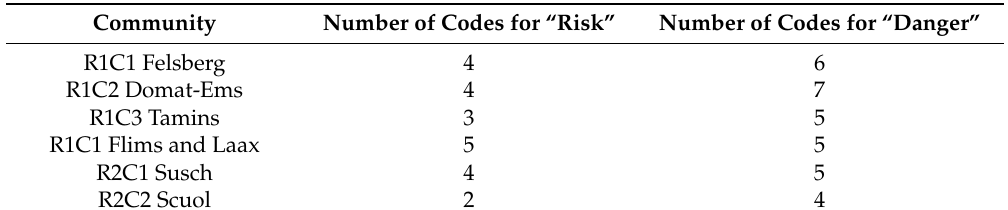
Table 5. Numbers of codes found.